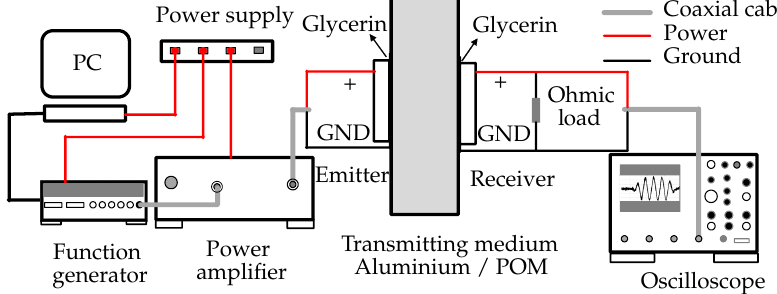
Figure 6. Experimental setup for ultrasonic power transmission